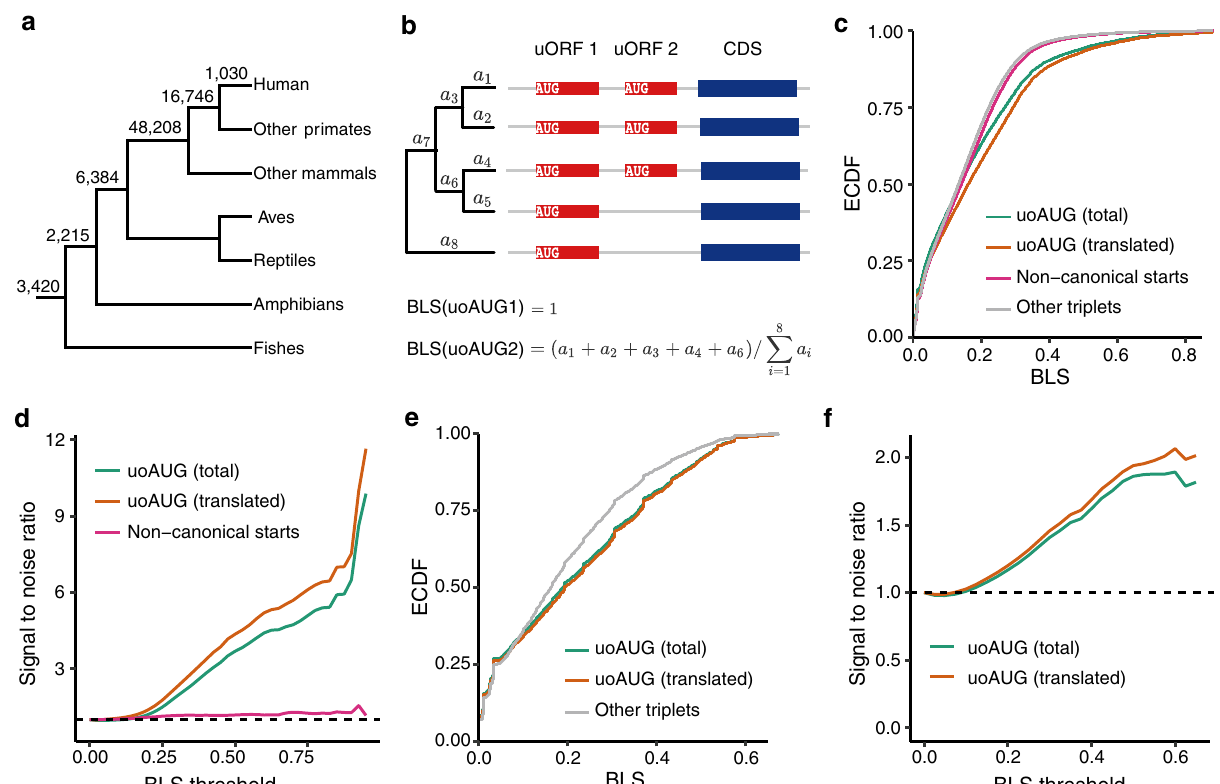
Fig. 3 Selective constraints on the upstream open reading frame (uORF) start codons. a Age distribution of start codons (uoAUGs) of human uORFs. The number of origination events assigned to each branch was inferred with the maximum parsimony method. b The scheme showing how the branch length scores (BLSs) for the start codons of two uORFs are calculated based on their presence or absence across species. In this hypothetical example, the length of each branch is denoted with a i ( i = 1 – 8). c Empirical cumulative distribution function (ECDF) of the BLSs for uoAUGs, noncanonical start codons, and the other triplets in human 5 ′ untranslated regions (UTRs). The BLS of uoAUGs (total or translated) or noncanonical start codons was signi fi cantly larger than that of the other triplets ( P < 8 × 10 − 58 , two-sided Wilcoxon rank-sum tests). d Signal-to-noise ratios of the BLSs of uoAUGs and noncanonical start codons relative to other triplets in humans based on different thresholds of minimum BLS. The dashed line delineates a signal-to-noise ratio of 1 expected under neutral evolution. e ECDF of BLS for uoAUGs and the other triplets in fl y 5 ′ UTRs. The BLS of uoAUGs (total or translated) was signi fi cantly larger than that of the other triplets ( P < 2 × 10 − 88 , two-sided Wilcoxon rank-sum tests). f The signal-to-noise ratio of BLSs for uoAUGs relative to other triplets in fl ies based on different minimum BLS thresholds. Source data are provided as a Source Data fi